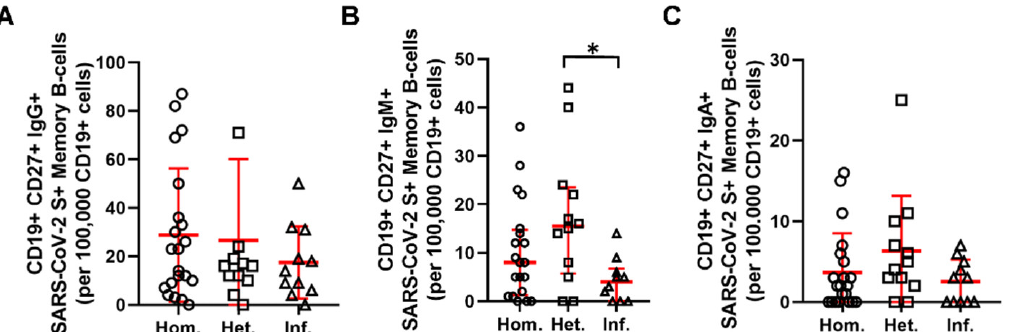
Figure 4. The proportion of ( A ) IgG+, ( B ) IgM+, ( C ) IgA+ SARS-CoV-2 S-antigen reactive memory (CD19+CD27+) B-cells in the three patient groups (circles: Hom. n = 21, squares: Het. n = 12, triangles: Inf. n = 11). Horizontal lines—median, whiskers—interquartile range. * p < 0.05 Het. vs. Inf.